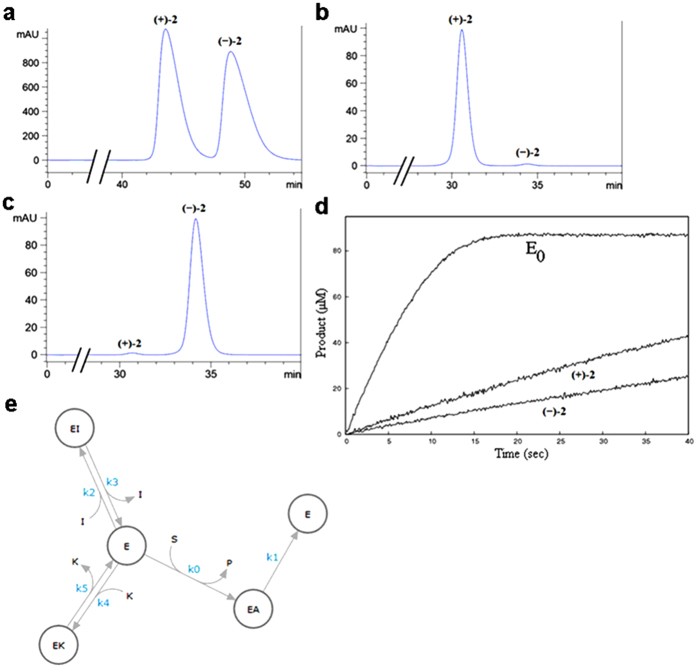
Chiral HPLC resolution of racemic compound (±)-2 into pure enantiomers, and their kinetic evaluation.(a) Semi-preparative reversed-phase HPLC of racemic compound (±)-2 (Supplementary Methods [method A; 254 nm]). (b) Analytical reversed-phase chiral HPLC of (+)-2 (Supplementary Methods [method B; 254 nm]). (c) Analytical reversed-phase chiral HPLC of (−)-2 (Supplementary Methods [method B; 254 nm]). (d) Progress curves for hydrolysis of 44 μM butyrylthiocholine iodide by huBChE in the absence (E0) and presence of 50 nM of each pure enantiomer of compound 2 (as indicated). Data were obtained using a stopped-flow apparatus. (e) A competitive single-step inhibition mechanism with fast association (high k2, k4) for each pure enantiomer fully reproduced the progress curves obtained. S, substrate; P, product; E, enzyme; EA, acylated enzyme; I, (−)-2; K, (+)-2; k0–k5, kinetic constants.